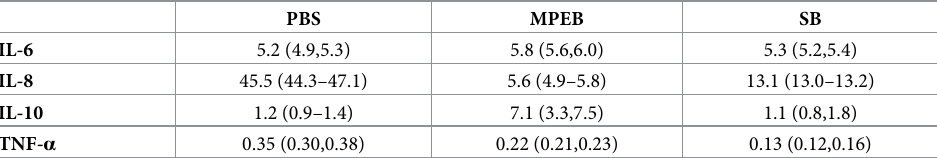
Table 1. Cytokine concentrations across three different homogenization buffers.